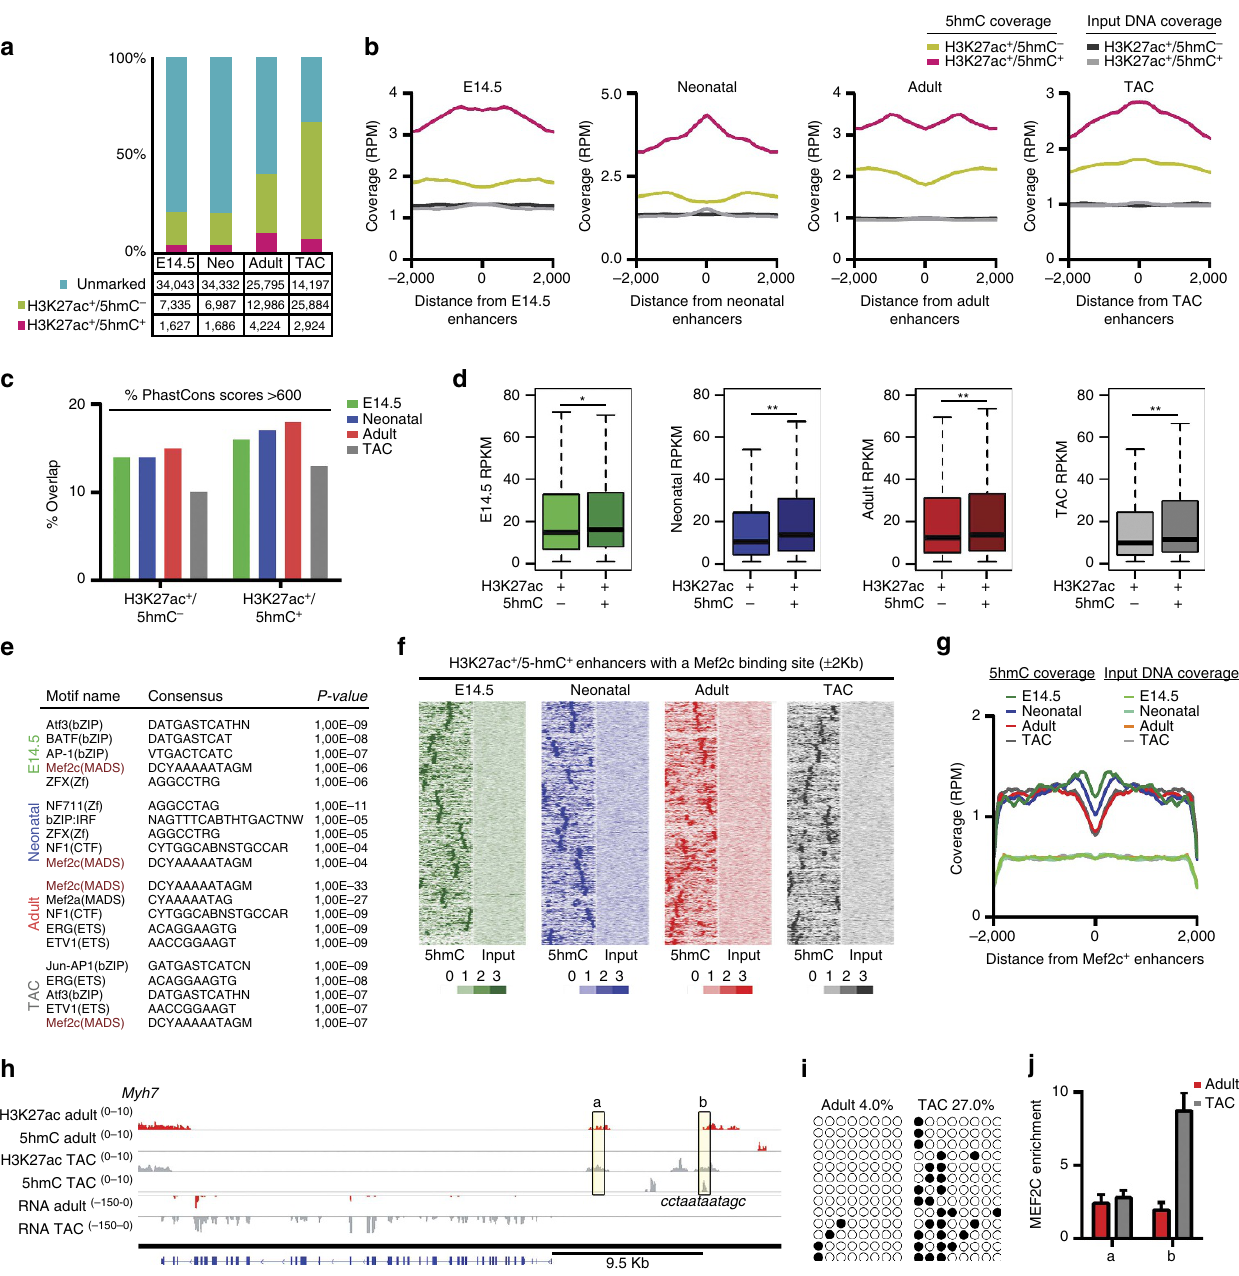
Figure 5 | 5-hmC-enriched enhancers. ( a ) Total enhancers identified in embryonic (E14.5), neonatal (Neo), adult and hypertrophic CMCs (TAC), categorized by H3K27ac and 5-hmC status. ( b ) Profiles of 5-hmC and input DNA coverage on H3K27ac þ enhancers in embryonic, neonatal, adult and hypertrophic CMCs. RPM, read counts per million mapped reads. Distance from enhancers in bp. ( c ) H3K27ac þ /5-hmC þ enhancers display